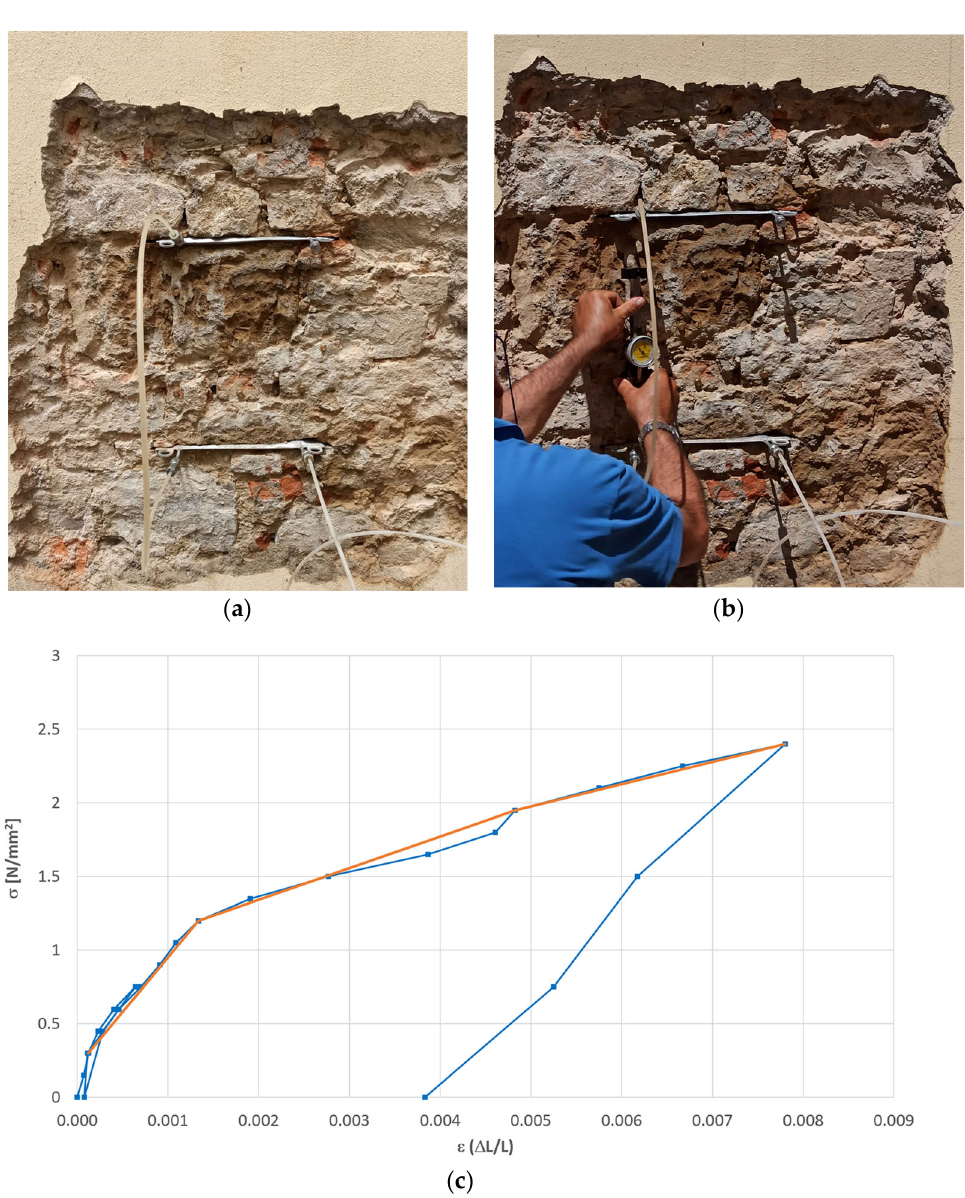
Figure 5. Double flat jack test carried out on a stone wall of the “Bernardo Rucellai” school: ( a ) test arrangement, ( b ) measurement of displacements, ( c ) experimental stress–strain diagram σ − ε in blue and tri ‐ linear approximation in orange.